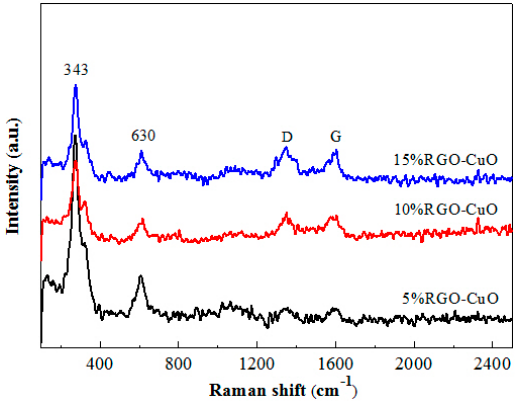
Figure 2. Raman spectra of RGO–CuO composites.